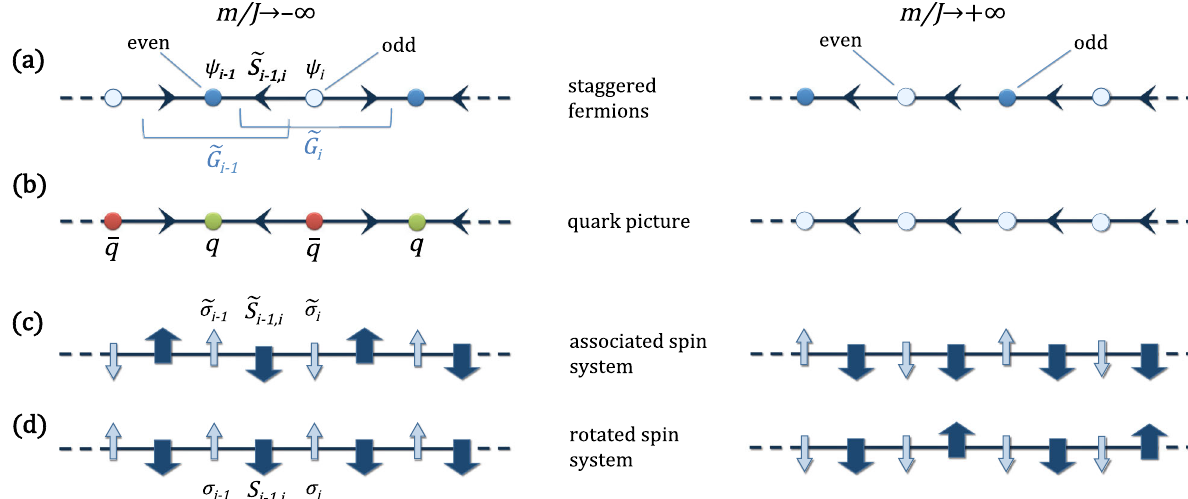
FIG. 2. Ground states of the QLM in several equivalent representations, for m=J ! (cid:1)1 (left) and m=J ! þ1 (right; only one of two degenerate solutions is drawn). Sketches are for vanishing quantum fluctuations ( J ¼ 0 þ ), periodic boundary conditions, and gauge fields represented by spins 1 = 2 . (a) Staggered-fermion QLM. Physical states are invariant under gauge transformations , which span one matter and two gauge fields. (b) Associated quark picture. Fermions on even sites correspond with generators ~ G i to quarks ( q , light green) and vacancies on odd sites to antiquarks ( (cid:1) q , dark red); the opposite configurations denote the absence of (anti)quarks. For m=J ! (cid:1)1 , alternating sources and drains of flux completely cover the chain, and the ground state is charge and parity invariant. For m=J ! þ1 , the system is empty of matter and has an unbroken flux string, breaking C and P symmetry. In this case, the Gauss law (4) requires the same orientation for all gauge fields, allowing a double energy degeneracy, corresponding to the two directions of electric flux (only one of which is visualized here). (c) Equivalent spin model ~ H Fermions are mapped to spins via the Jordan-Wigner transformation. For S ¼ 1 = 2 quantum links, right- (left-) flowing flux for experimental implementation. At m=J ! (cid:1)1 , the translates to an up (down) gauge-field spin. (d) Rotated spin model H P P QLM h S z i ¼ (cid:1) 1 and h (cid:5) z i ¼ 1 . In the C - and P -breaking state at m=J ! (cid:1)1 , they take order parameters are characterized by P P i i i i;i þ 1 h S z i ¼ 0 and h (cid:5) z i ¼ (cid:1) 1 the values i i i i;i þ 1